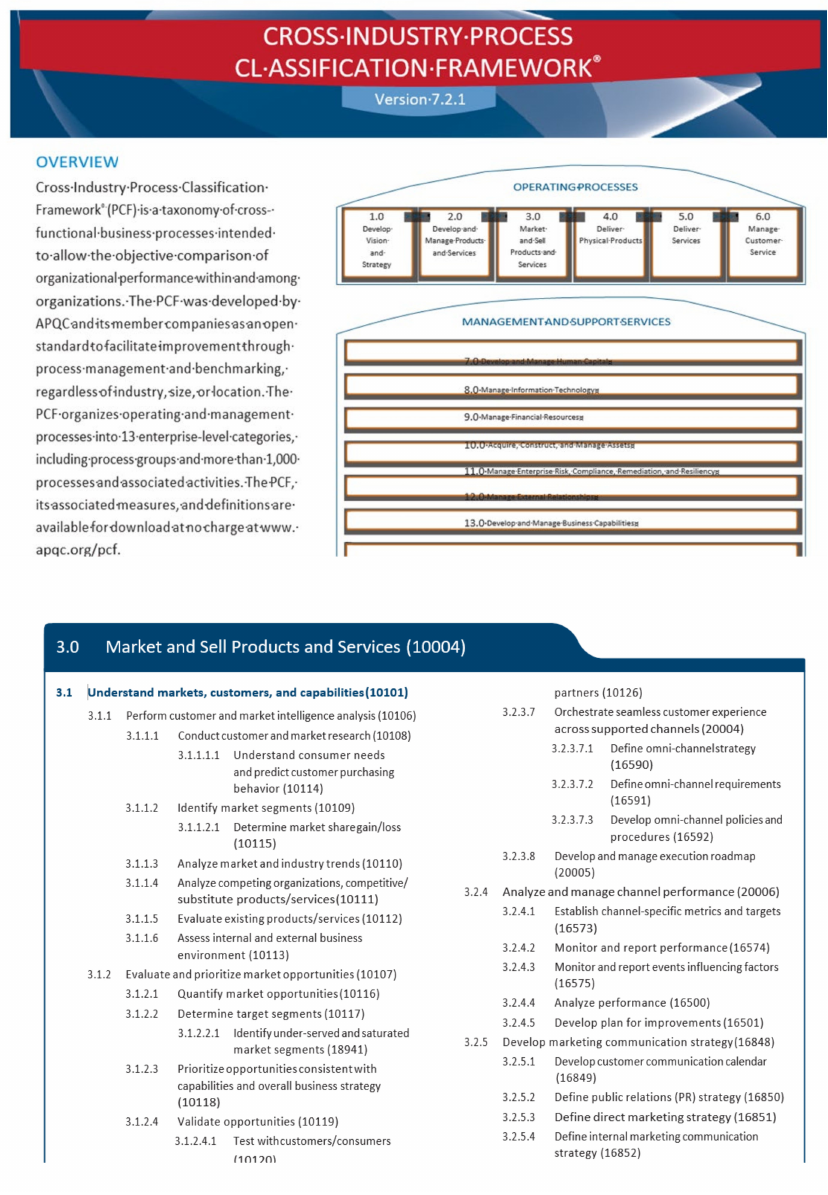
Figure 1. APQC cross-industry process classification